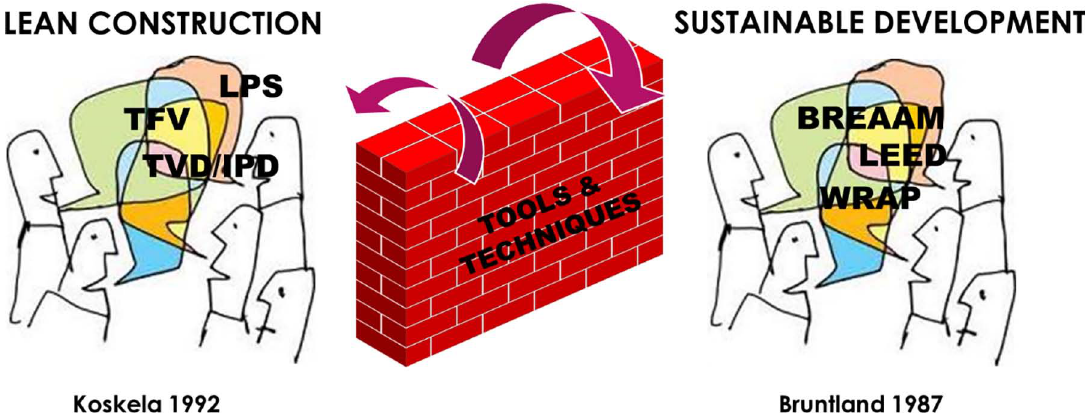
Figure 1. Research problem being addressed in this special issue (adapted from Sarhan, et al., 2019; courtesy: Christine